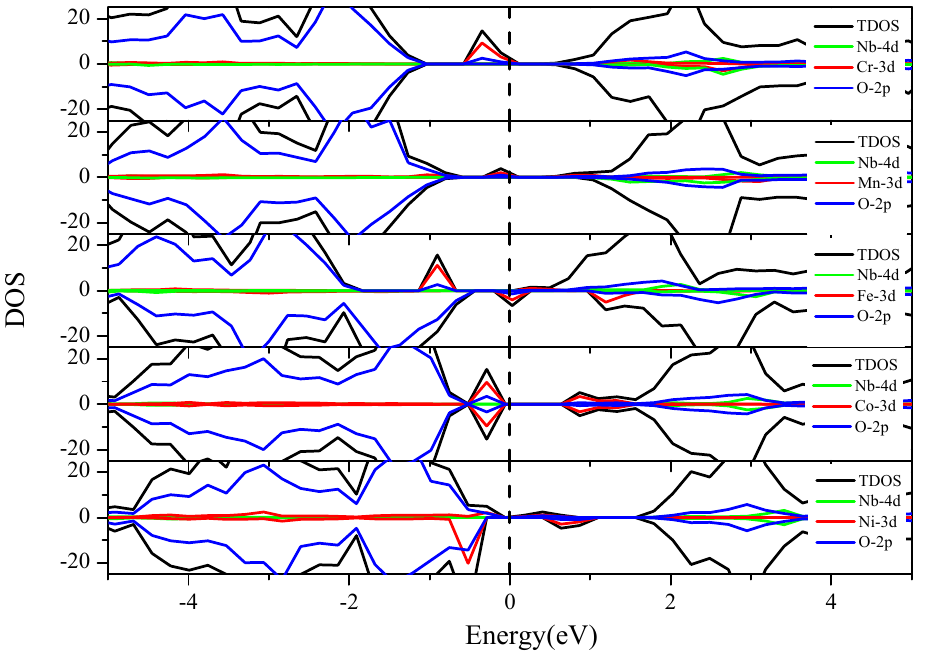
Figure 7. The total and partial density of states of the Nb-M ″ (3d metal elements: Cr, Mn, Fe, Co, and Ni) co-doped BaTiO 3 . The black dashed line indicates the position of the Fermi level.